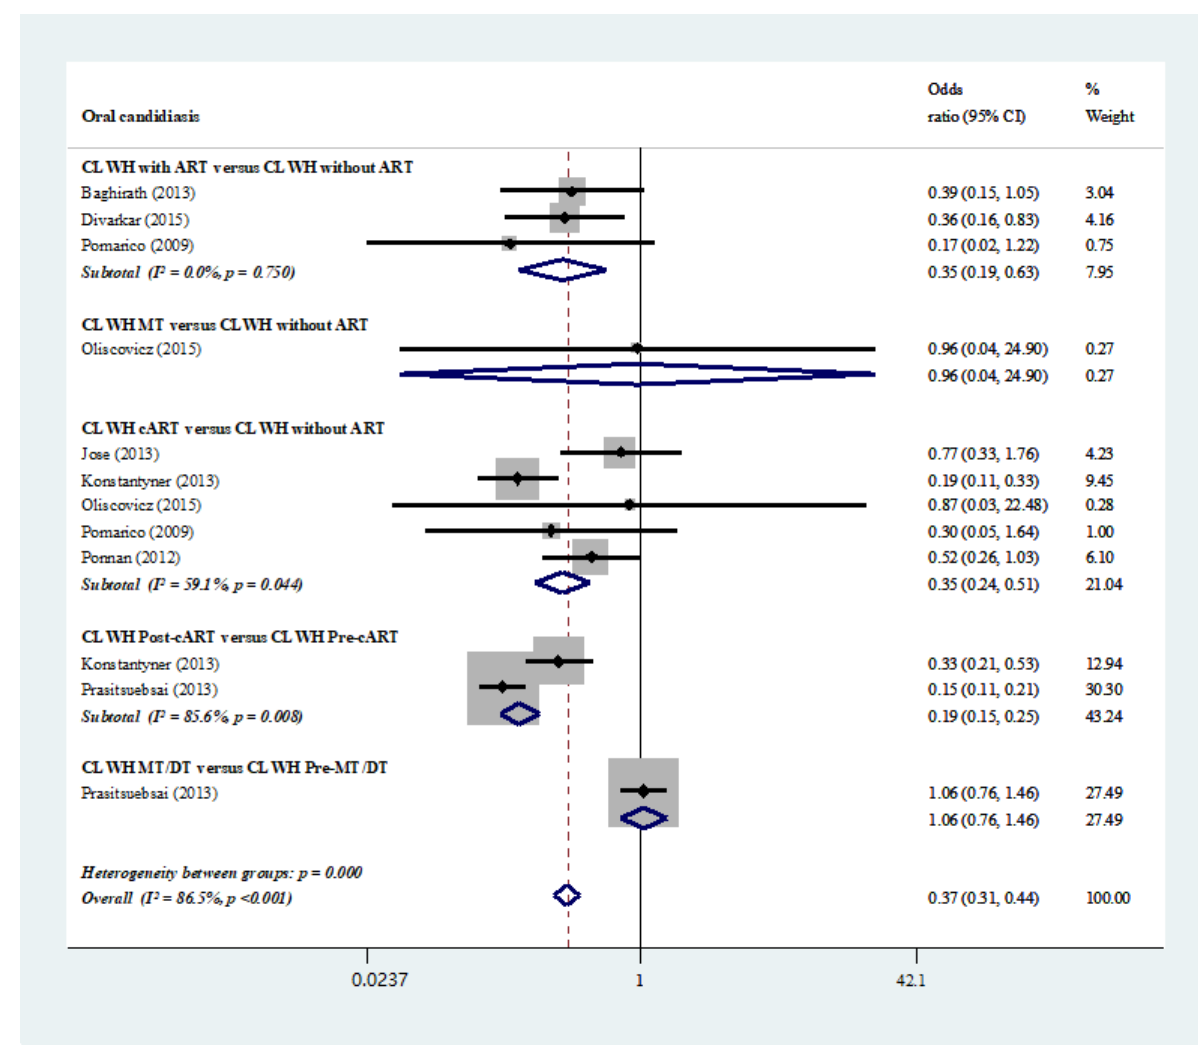
Figure 4. Prevalence of oral candidiasis: HIV-infected individuals under antiretroviral medications versus those without medications